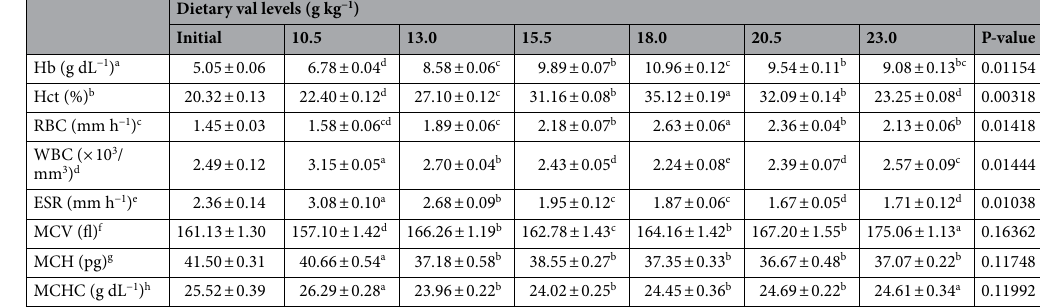
Table 3. Haematological indices of rainbow trout, Oncorhynchus mykiss fingerlings fed diets containing varying levels of dietary valine for 8-weeks (mean values of 3 replicates + SEM; n = 3) * a Hb, Hemaglobin; b Hct, Hematocrit; c RBC, Red blood cell; d WBC, White blood cell; e ESR, Erythrocyte sedimentation rate; f MCV, Mean cell volume; g MCH, Mean corpuscular hemoglobin; h MCHC, Mean corpuscular hemoglobin